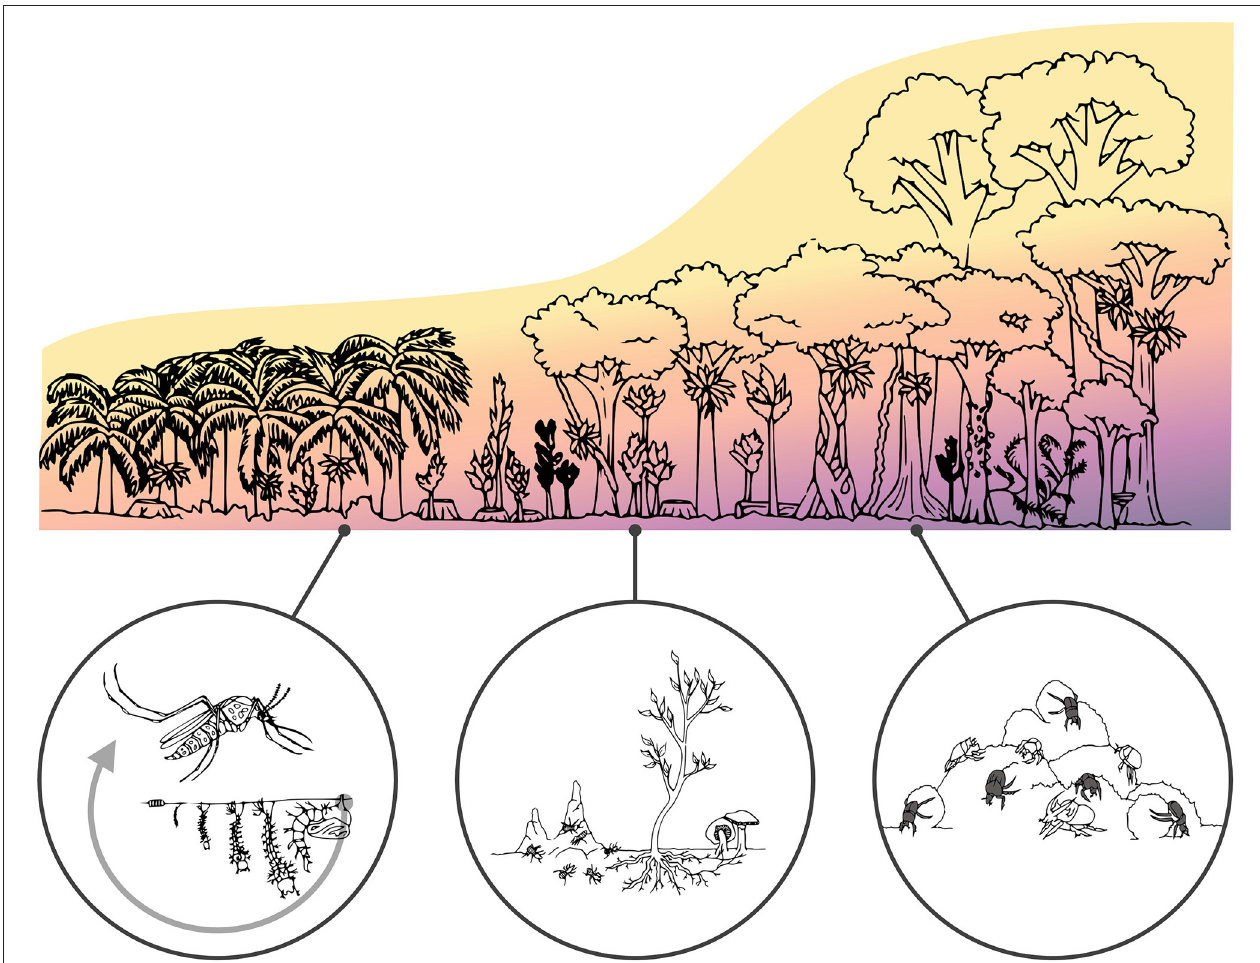
FIGURE 3 | Microclimate heterogeneity across a human-modified tropical forest landscape. Red hues denote warmer and drier microclimates, while blue ones depict cooler and more humid habitats. Figure inserts relate to Case studies 1–3 in the main text. They highlight examples of how microclimatic variation across this disturbance gradient can influence population dynamics of disease vectors (left) , interactions among trophic groups such as those between tree seedlings, termites and fungi (middle) , as well as shaping the community composition of functionally important groups such as dung beetles (right)